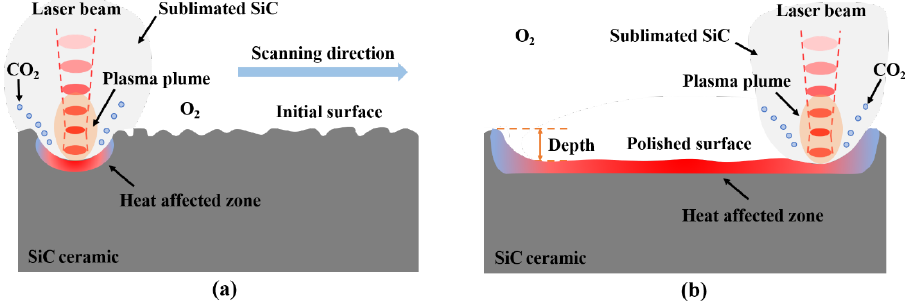
Figure 6. The schematic diagram of femtosecond laser polishing of SiC ceramics. ( a ) Before polishing and ( b ) after polishing.